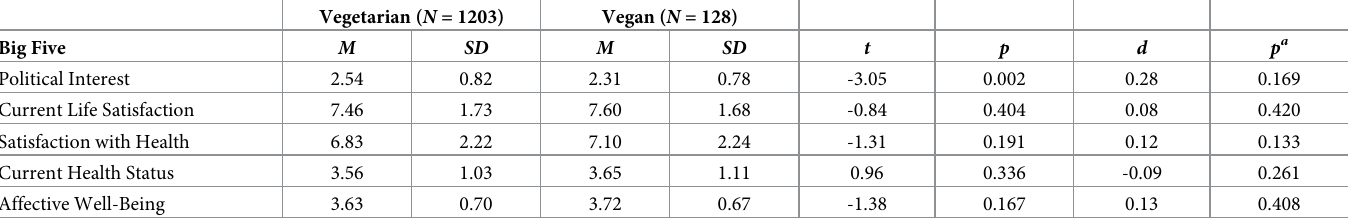
Table 3. Main study: Results of exploratory analyses of political interest, current life satisfaction, satisfaction with health, current health status as well as affective well-being as a function of eating